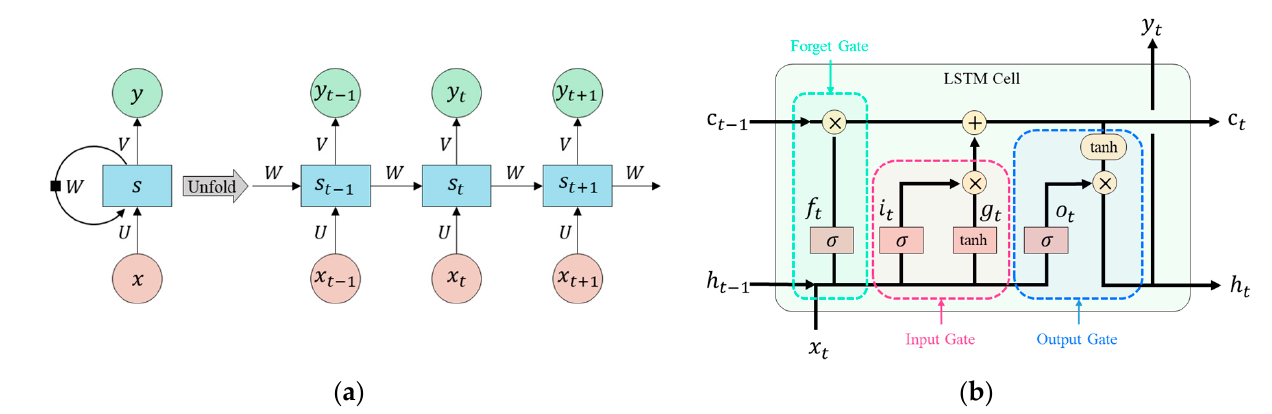
Figure 3. B asic architecture of the RNN and LSTM models [33]. (x: input data, y: output data, s: hidden data, U, V, W: weight, f t : forget gate, i t : input gate, o t : output gate, h: hidden-state, c: cell-state). ( a ) RNN model. ( b ) LSTM model.